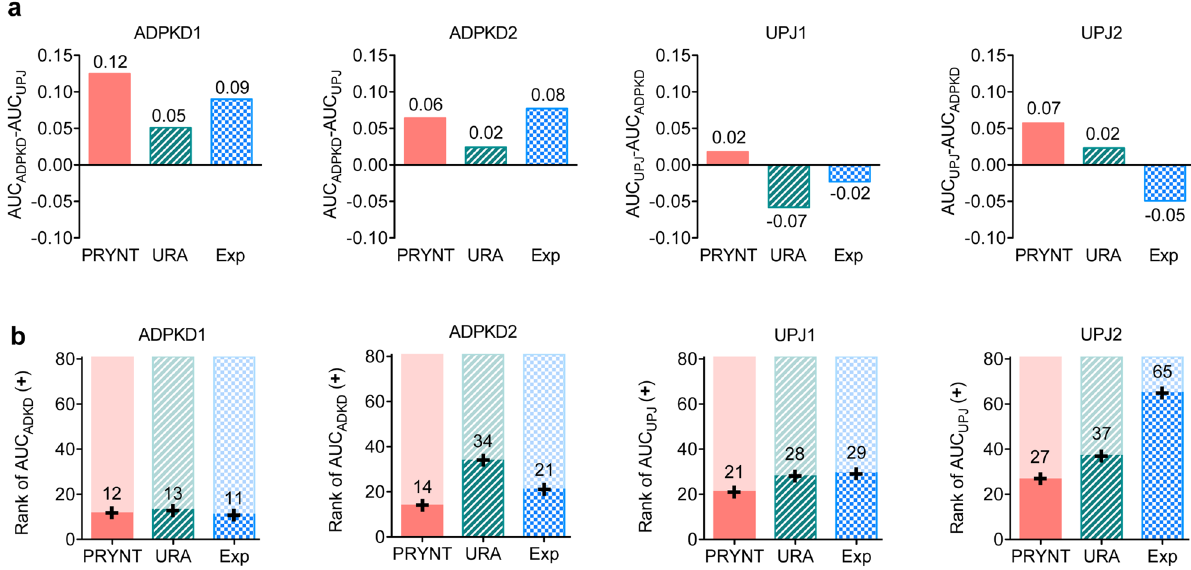
Figure 6. Specificity of PRYNT compared to reference approaches. ( a ) Cross-specificity of the prioritization strategies was assessed for the four datasets by calculating the difference between the AUC of the precision curve for specific disease candidates (AUC ADPKD for ADPKD datasets and AUC UPJ for UPJ datasets) and the AUC of non-specific disease candidates (AUC UPJ for ADPKD datasets and AUC ADPKD for UPJ datasets). ( b ) Overall specificity of the prioritization strategies was assessed for the four datasets by assessing the rank of the AUC of the precision curve for specific reference disease candidates (AUC ADPKD for ADPKD datasets and AUC UPJ for UPJ datasets) compared to 80 additional AUCs of reference candidates from non-specific diseases, including 40 diseases associated to urogenital tract and 40 diseases from other origin. Graphs were designed using GraphPad Prism version 5.0 for Mac, GraphPad Software, San Diego, California USA, http://www.graph pad.com. Exp: experimental, URA: upstream regulator